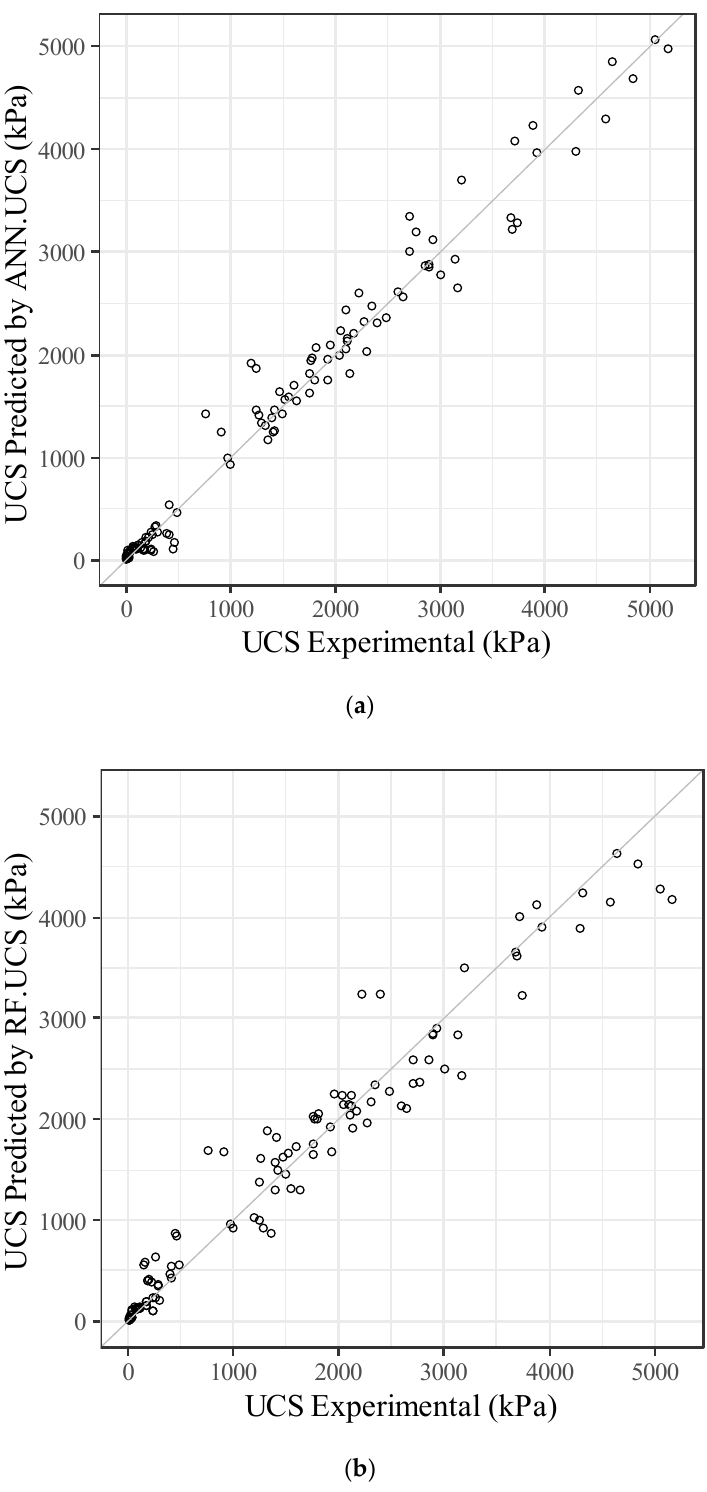
Figure 4. The relationship between UCS experimental versus predicted values of soil–binder–water mixtures reinforced with fibers according to: ( a ) the ANN.UCS model; ( b ) the RF.UCS model.